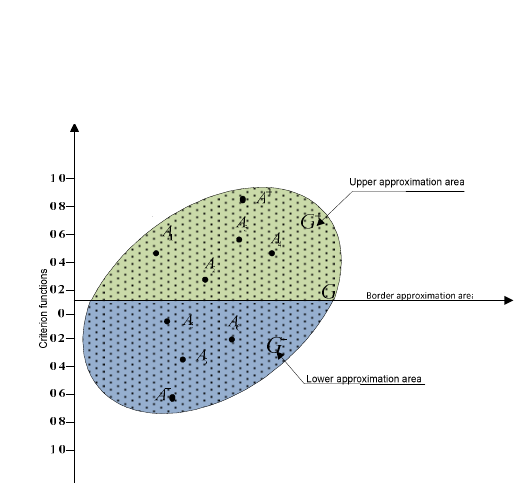
+ − Figure 3 – Presentation of the upper ( G ), lower ( G ) and border ( G ) approximation areas (Pamu č ar, Ć irovi ć , 2015) + − ), нижней ( G ) и предельной ( G ) Фигура 3 – Изображение верхней ( G аппроксимативной области (Pamu č ar, Ć irovi ć , 2015) + − ), donje ( G ) i grani č ne ( G ) aproksimativne oblasti Slika 3 – Prikaz gornje ( G (Pamu č ar, Ć irovi ć ,